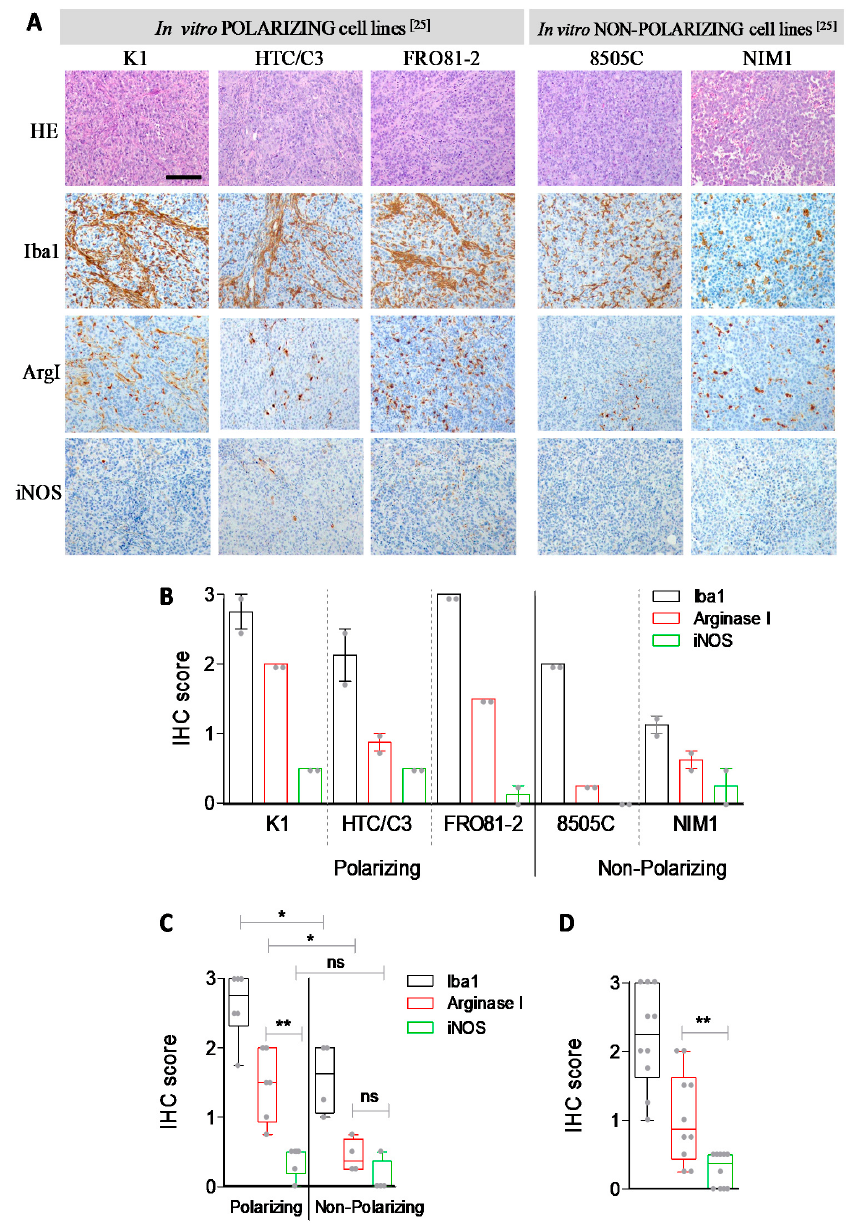
Figure 4. Immunohistochemical analysis of tumor explants. ( A ) H&E, Iba1, ArgI and iNOS immuno- histochemistry in thyroid tumor xenografts; representative pictures of the indicated tumor cell lines tumor explants. 200× magnification, BAR = 100 µm ( B ) Barplot (mean ± SEM) with scatterplot show- ing IHC scores of the corresponding cell lines (see material and methods); two animals for each cell line were tested. The same results are showed ( C ) in samples stratified for in vitro M2-like polariza- tion capacity or ( D ) as unique class. Each dot represents IHC score computed as mean of at least four (40×) fields scored for each xenograft (see Figure S3). Statistical significance by non-parametric Mann–Whitney test; ** p -value < 0.01 and * p -value < 0.05.